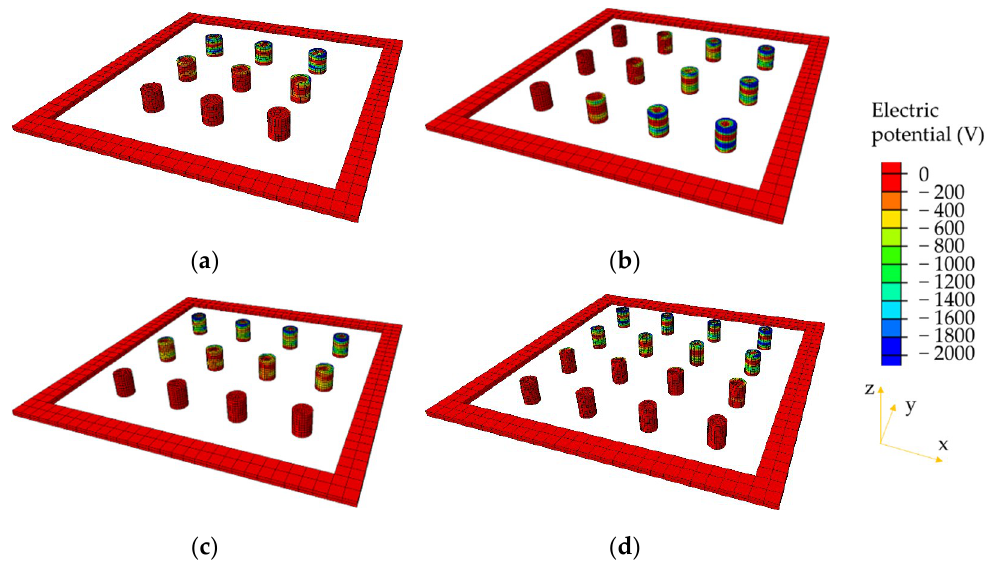
Figure 11. Electrical potential distributions in piezoelectric units under half loading condition: ( a ) 3 × 3 with diameter = 2 cm; ( b ) 3 × 4 with diameter = 1.73 cm, along x-direction; ( c ) 3 × 4 with diameter = 1.5 cm, along y-direction; ( d ) 4 × 4 with diameter = 1.5 cm.